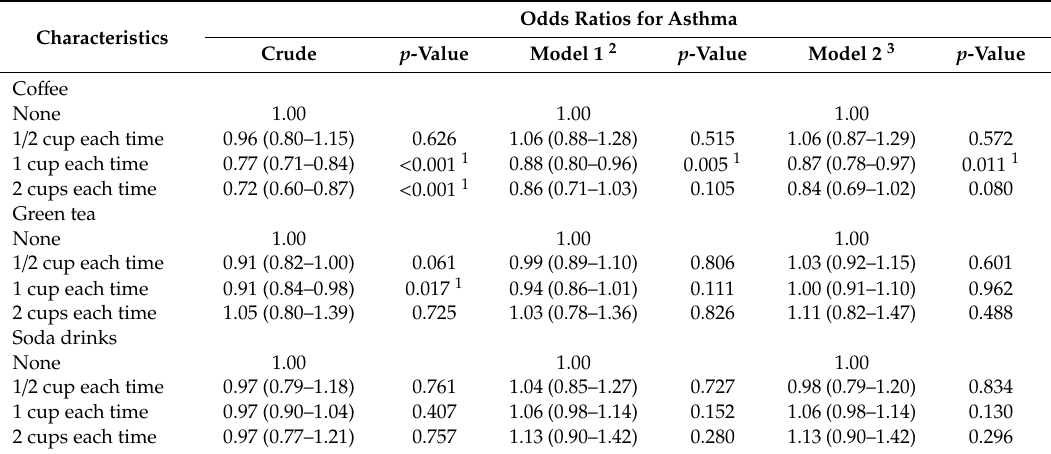
Table 3. Crude and adjusted odds ratios (95% confidence interval) for asthma by co ff ee, green tea, and soda drink intake